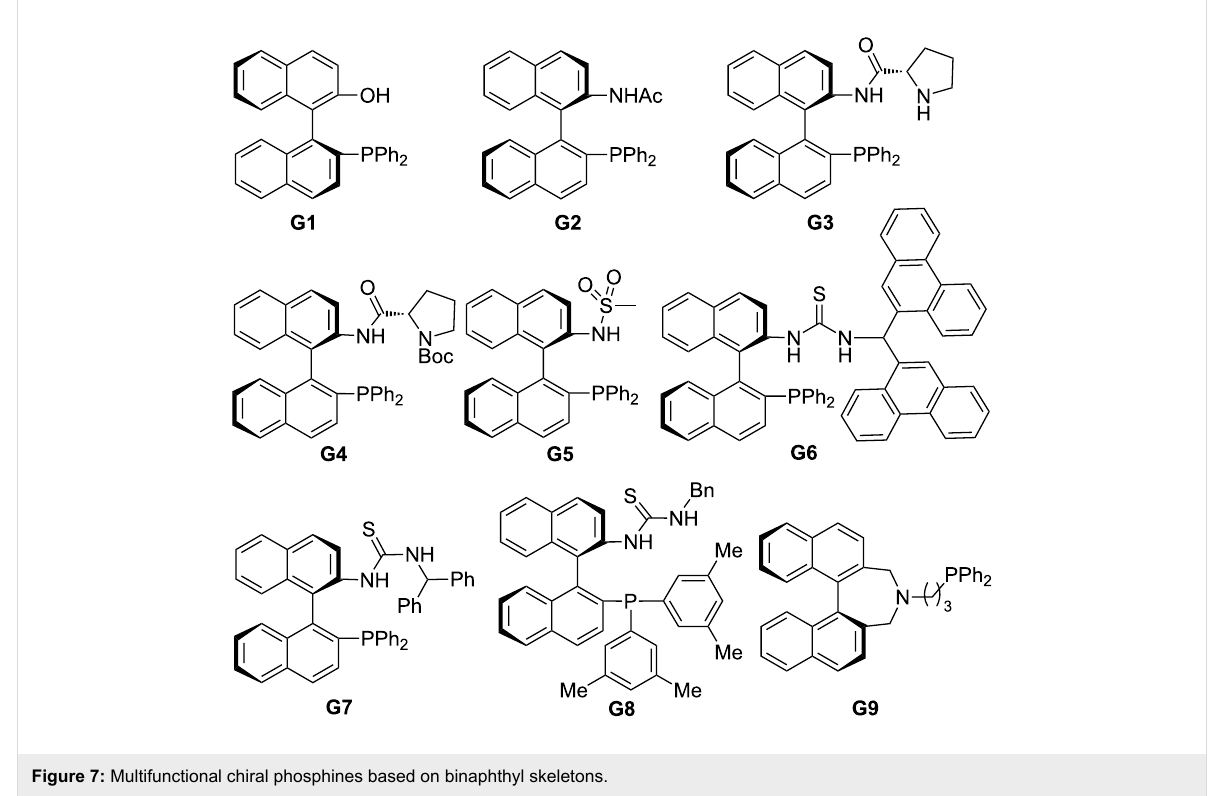
Figure 7: Multifunctional chiral phosphines based on binaphthyl skeletons.